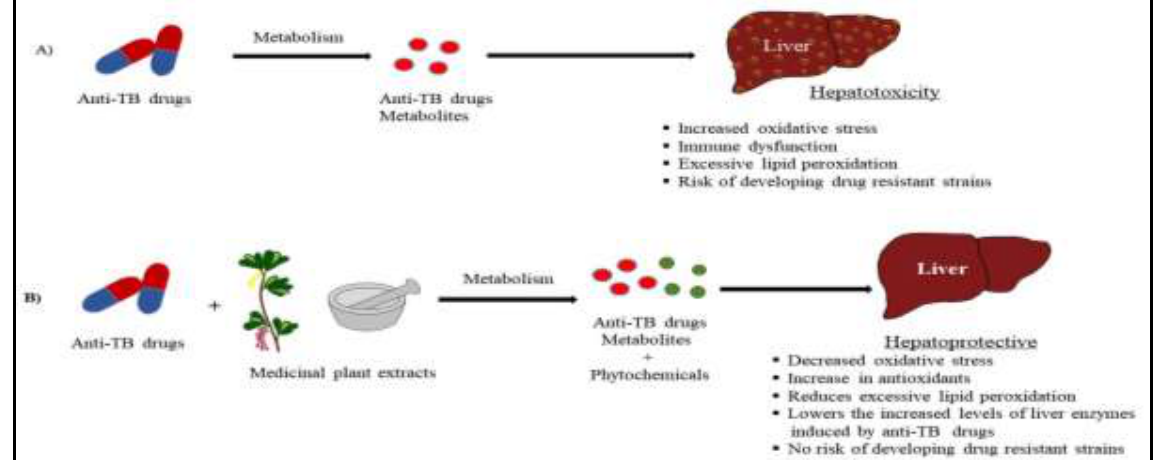
Figure 1. Hepatoprotective role of phytochemicals against synthetic anti-TB drugs(Adapted from Mangwani et al, 2020)